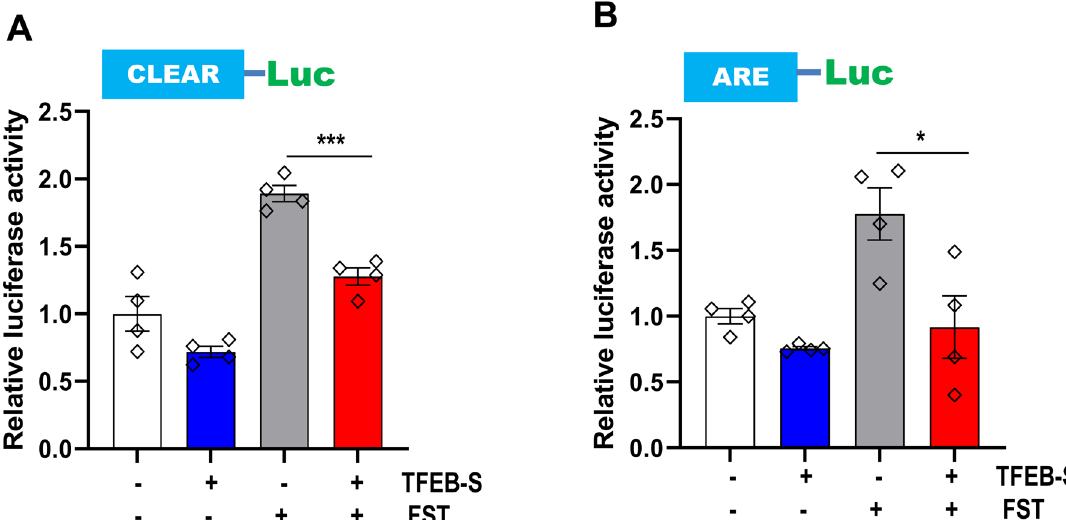
Figure 5. Small TFEB attenuates fisetin-induced transcriptional activity of TFEB and Nrf2. HEK293 cells were transiently co-transfected with either CLEAR-Luc or ARE-Luc reporter plasmids and either the